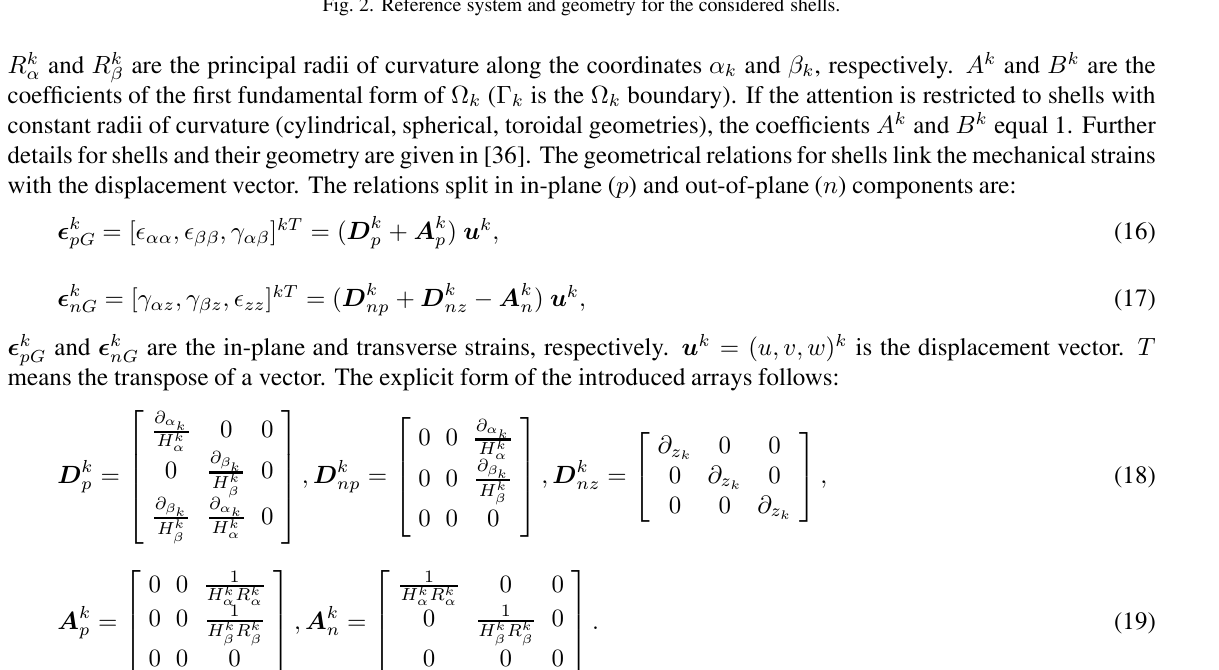
Fig. 2. Reference system and geometry for the considered